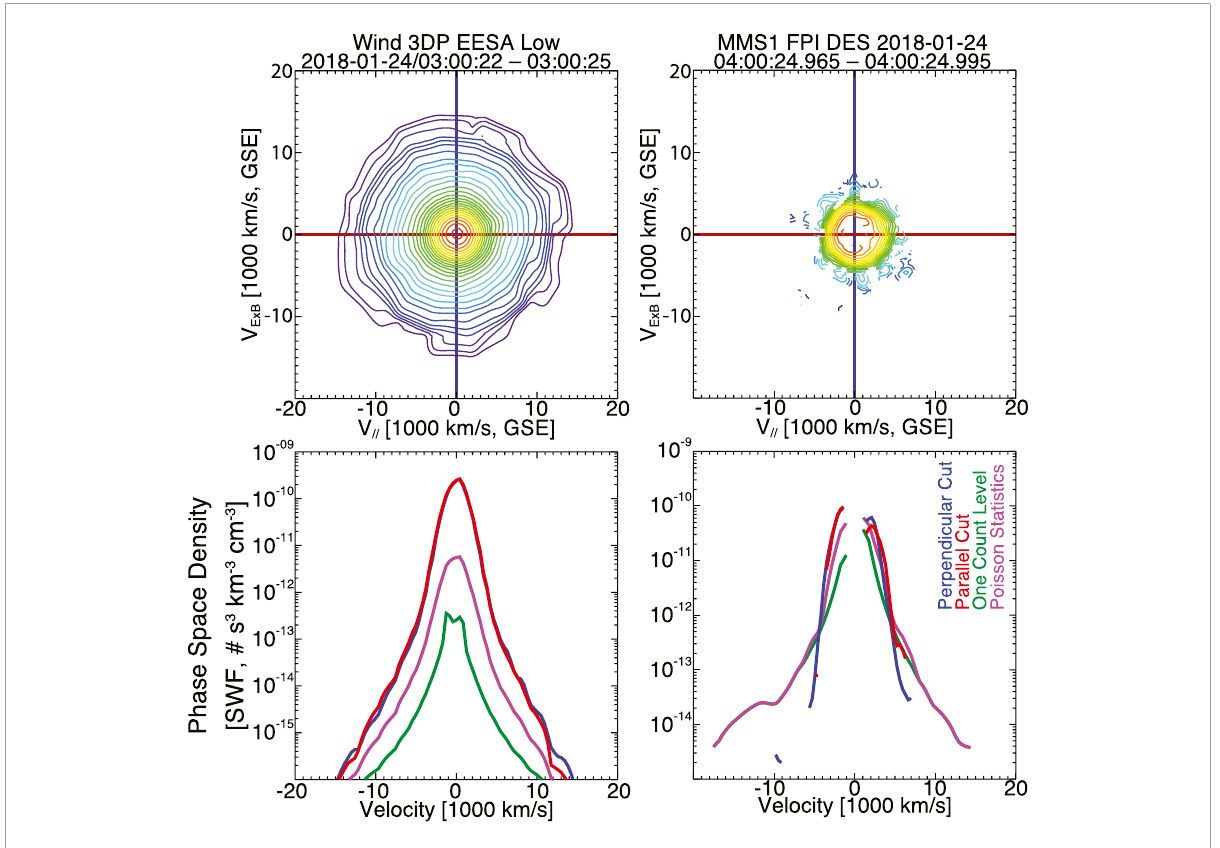
FIGURE 1 Illustrative example electron VDFs from Wind 3DP (Wilson et al., 2021) and MMS DES (Pollock et al., 2016). The top row shows contours of constant phase space density [ cm −3 km −3 s +3 ] of a two-dimensional cut through a three-dimensional VDF. The plane and coordinate basis are defined by the quasi-static magnetic field, B o , and the ion bulk flow velocity, V i . The vertical axis is defined by the unit vector ( B o × V i )× B o and the horizontal by B o . The bottom row shows one-dimensional cuts of the VDF along the horizontal (solid red line) and along the vertical (solid blue line). The location of these cuts are defined by the color-coded cross hairs in the top row panels. Also shown are the one-count (solid green line) and Poisson statistics (solid magenta line) levels for reference. The VDF is shown in the ion bulk flow rest